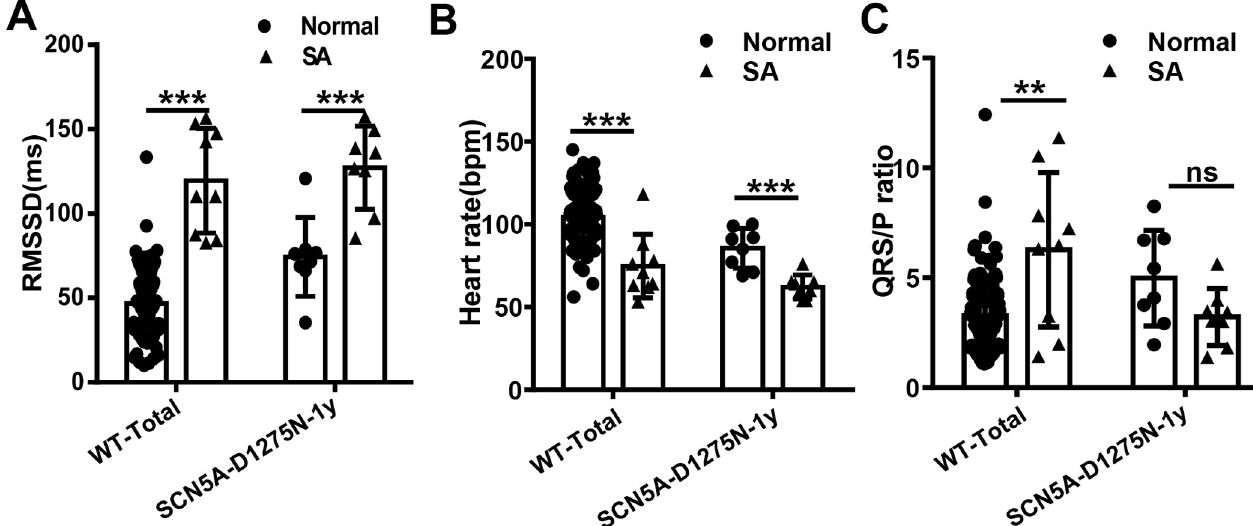
Fig 6. Obvious features of Sinus Arrest (SA) exist in SA-like subgroup compared with normal fish. A, Root mean square of successive differences (RMSSD) of wild-type (WT) and Tg(SCN5A-D1275N) fish in SA subgroup is higher than in normal fish. B, Heart rate of WT and Tg(SCN5A-D1275N) fish in SA subgroup is lower than in normal fish. C, QRS/P ratio of WT and Tg(SCN5A-D1275N) fish in SA subgroup is larger than in normal fish. �� P < .01 and ��� P < .001 (nonparametric tests). bpm indicates beats per